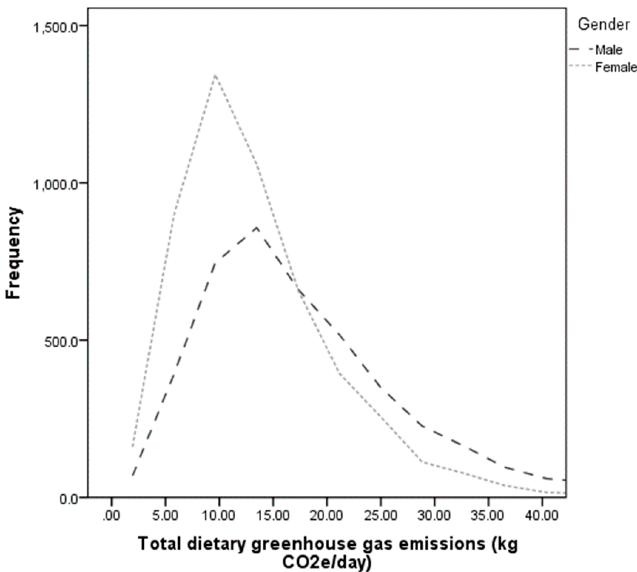
Figure 1. Distribution of total dietary greenhouse gas emissions for Australian males (black dashed line, n = 4282) and Australian females (grey dotted line, n = 5059).